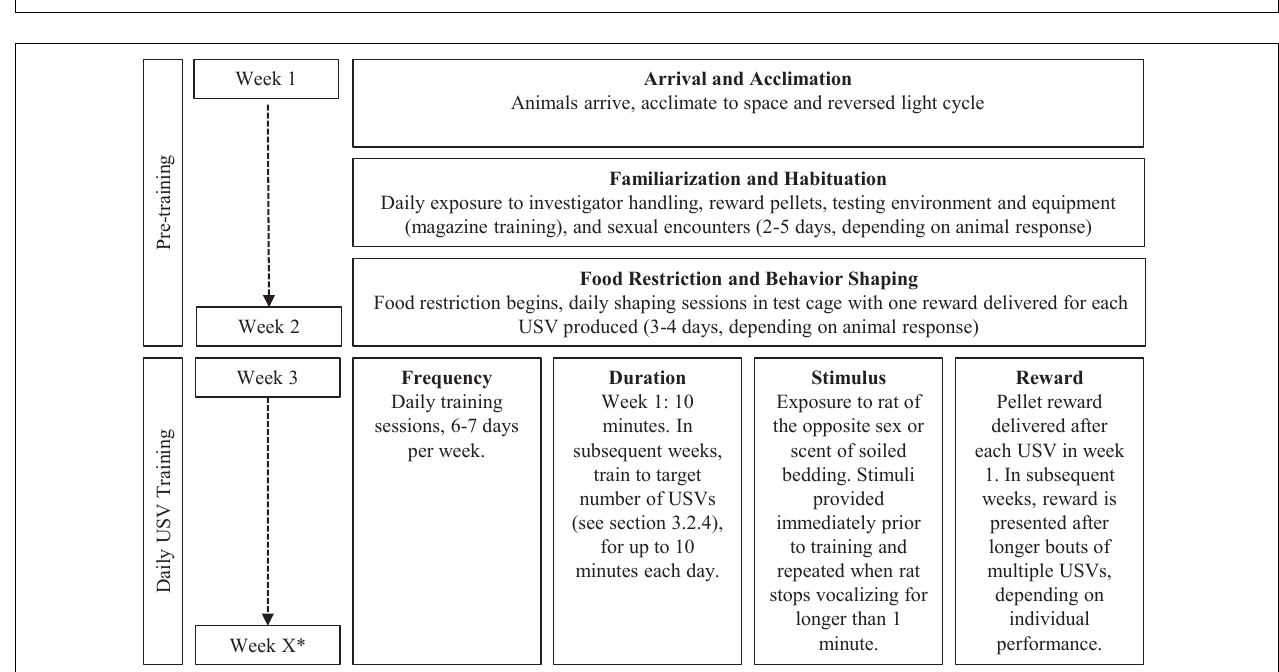
Frequency Daily training sessions, 6-7 days per week.